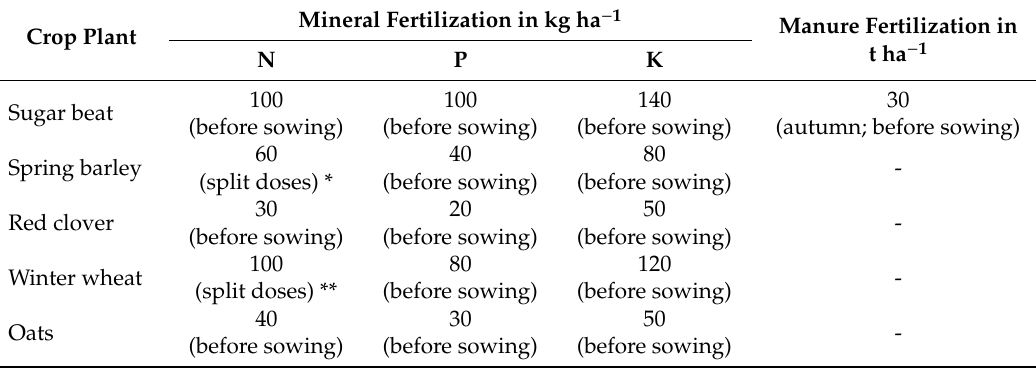
Table 2. Fertilization applied in the conventional system.